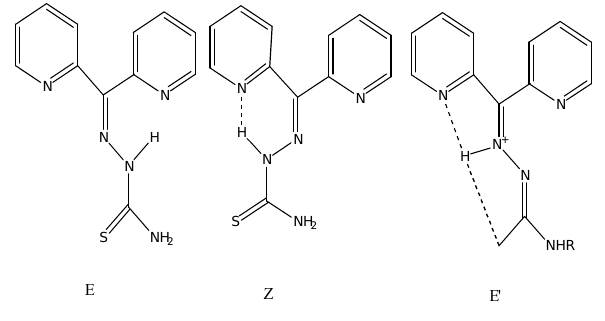
Figure 2: Thiosemicarbazone molecule as thione or tautomeric forms in